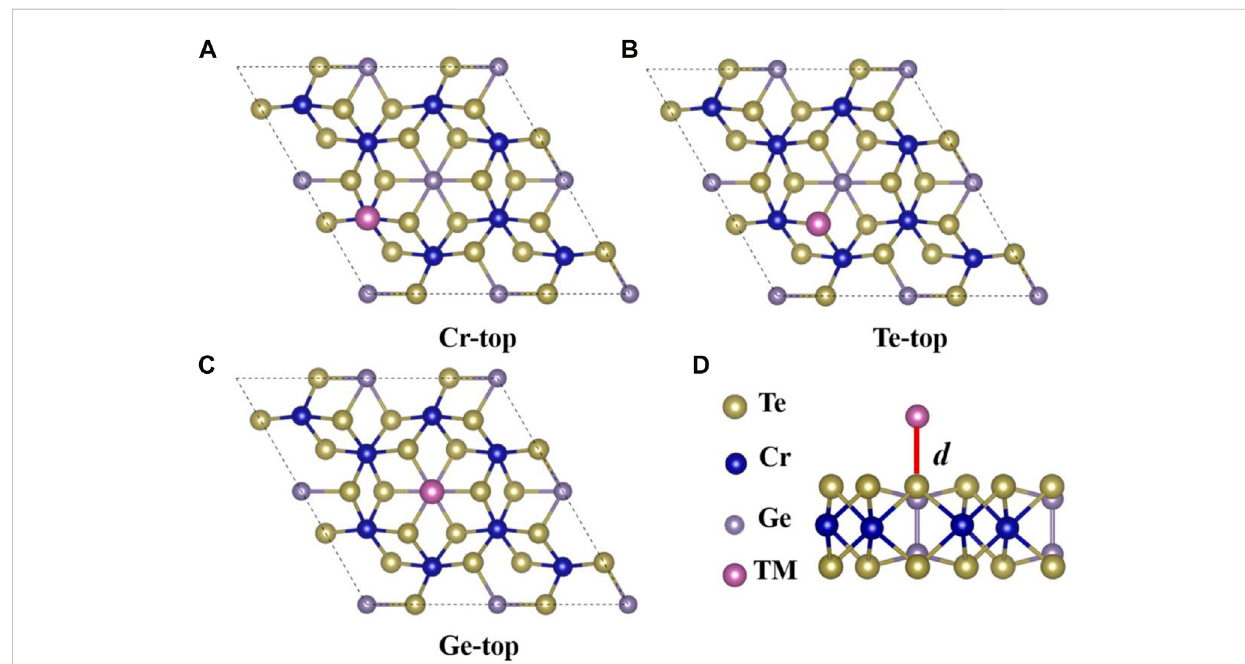
FIGURE 1 Thetop viewsofthecrystallinestructureofa2×2monolayerCr 2 Ge 2 Te 6 ,with TMatomsabsorbedatthreedifferentpositions labeledas (A) Cr-top, (B) Te-top,and (C) Ge-top,respectively.Thedottedblacklinesinthegraphindicatethe2×2supercell. (D) ThesideviewofthemonolayerCr 2 Ge 2 Te 6 (2× 2) nanosheet adsorbed by the transition metals, and the adsorption distance d is represented by the solid red line. The atoms of the Te, Cr Ge, and 3 d transition metals are represented by the pale yellow, indigo, purple, and pink balls represent,